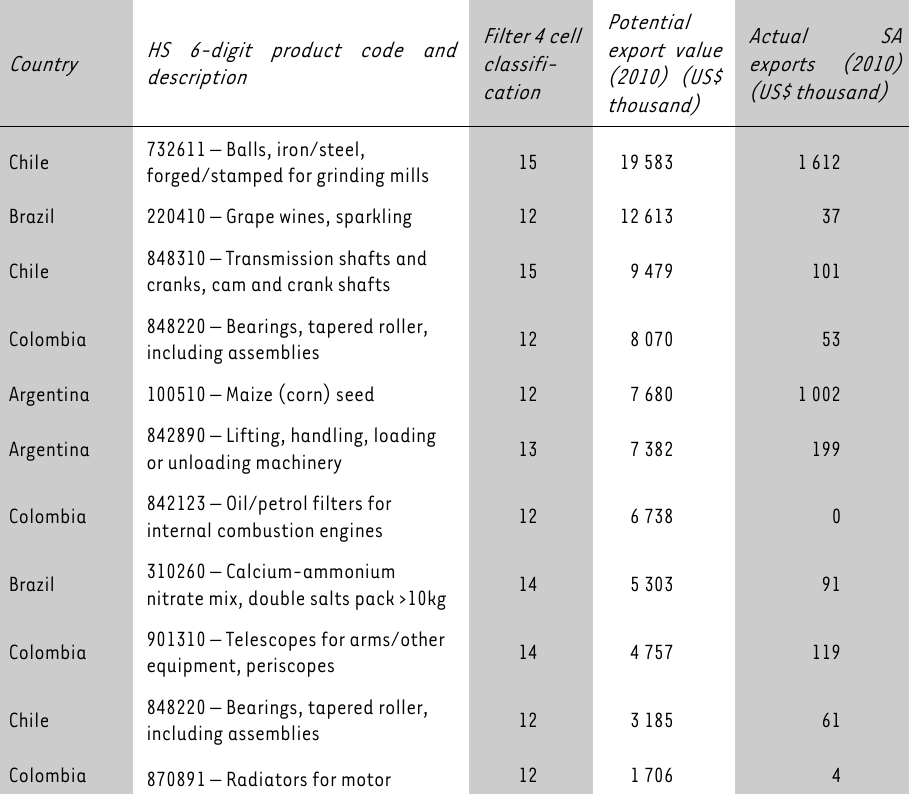
TABLE 13: Identified product-country combinations assigned to Cells 11 to 15 HS 6-digit product code Country